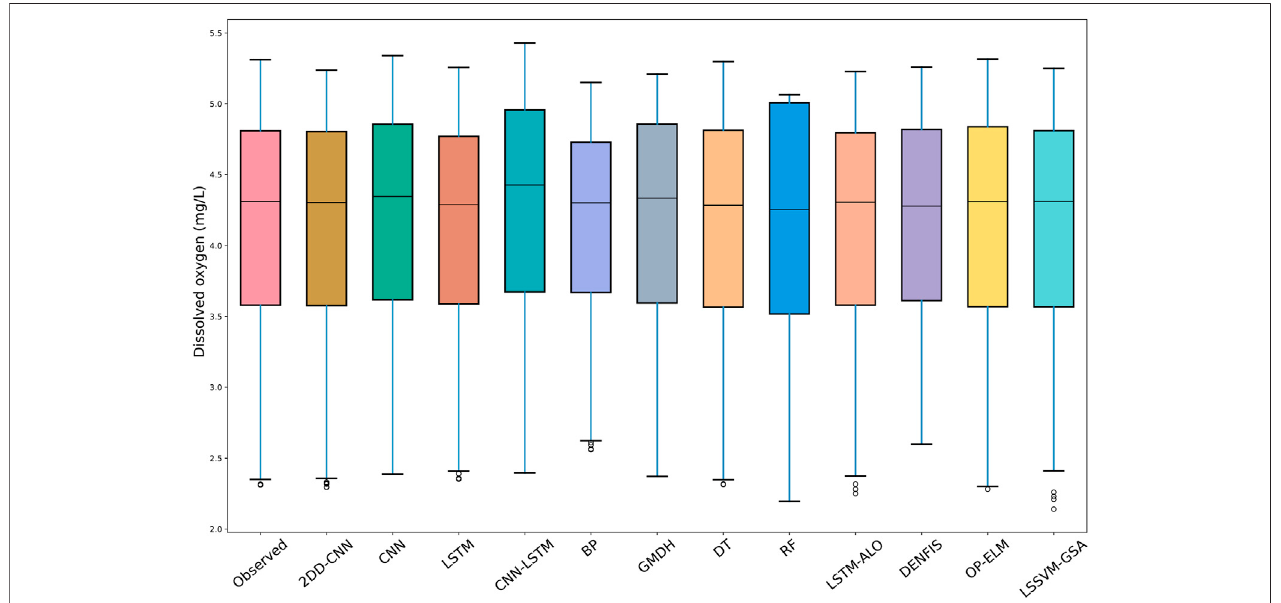
FIGURE 7 | Comparison of predicted and observed values of DO for different